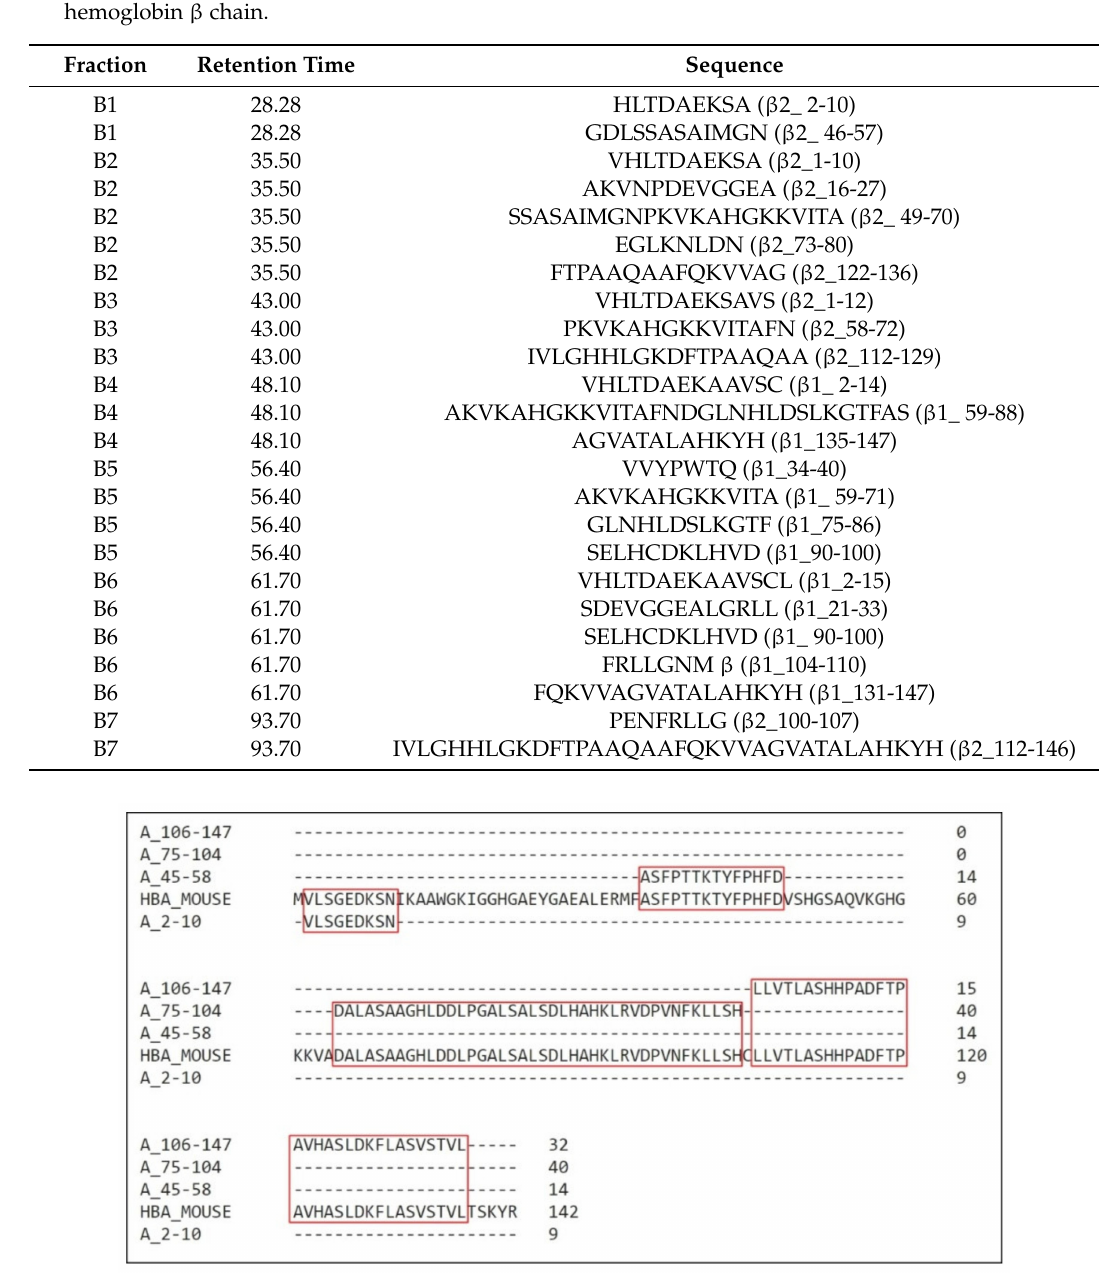
Table 3. Mass spectrometry data database search ( β chain results). Fraction B1 (eluted at 28.28 min) has two peptides corresponding to the fragments 2–10 and 56–77 of the hemoglobin β chain. Fraction B2 (eluted at 35.5 min) has five peptides corresponding to the fragments 1-10, 16–27, 49–70, 73–80 and 122–136 of the hemoglobin β chain. Fraction B3 (eluted at 43 min) has three peptides corresponding to the fragments 1–12, 58–72 and 112–129 of the hemoglobin β chain. Fraction B4 (eluted at 48.1 min) has three peptides corresponding to the fragments 2–14, 59–88 and 135–147 of the hemoglobin β chain. Fraction B5 (eluted at 56.4 min) has four peptides corresponding to the fragments 34–40, 59–71, 75–86 and 90–100 of the hemoglobin β chain. Fraction B6 (eluted at 61.7 min) has five peptides corresponding to the fragments 2–15, 21–33, 90–100, 104–110 and 131–147 of the hemoglobin β chain. Fraction B7